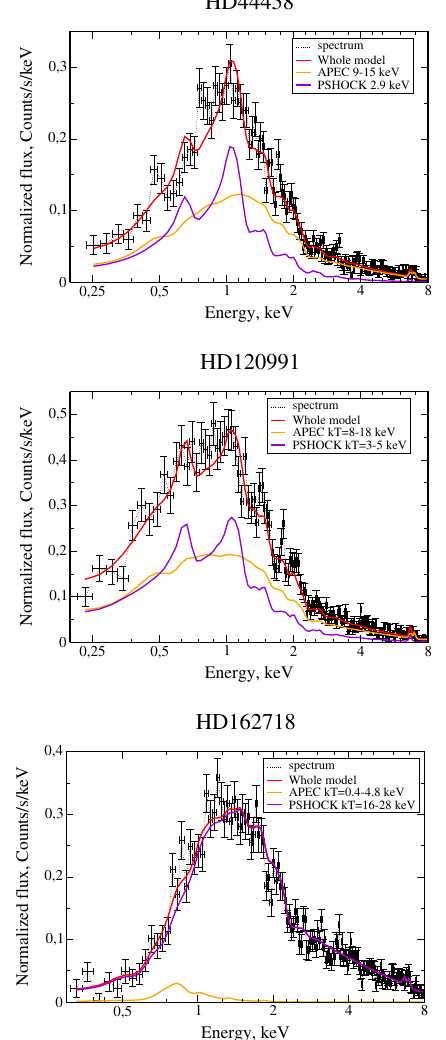
Figure 2. The same as in Figure 1 but for APEC/MEKAL+PSHOCK